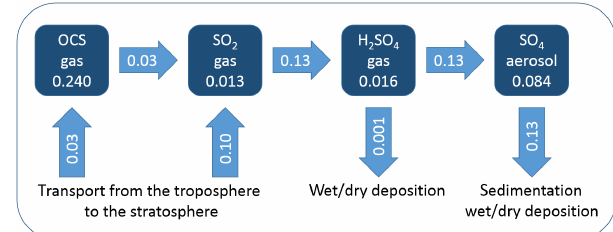
Figure 6. Modelled annual mean stratospheric burden (in TgS) and fluxes (in TgSyr − 1 ) of the represented sulfur species. The values are given for steady-state background conditions without any strato- spheric volcanic emissions. Advection can take the species out of the stratosphere into the troposphere, where they can be removed by wet and dry